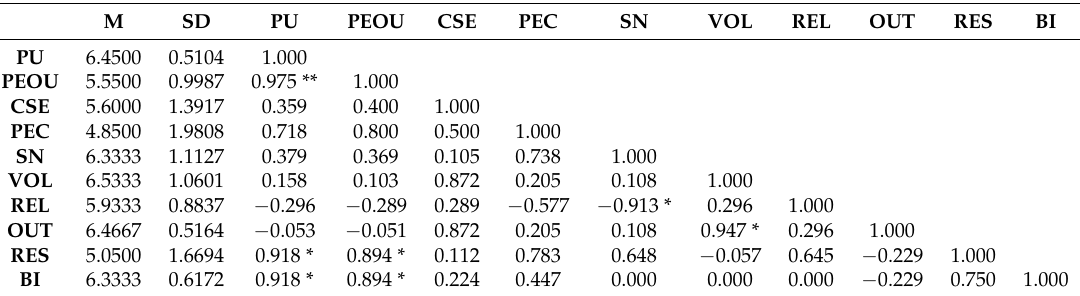
Table 6. TAM3 results. Columns M and SD show the average and standard deviation of all explored parameters, respectively. The Spearman correlation coefficient and its significance among the explored variables are also shown. (*) p < 0.05, (**) p <